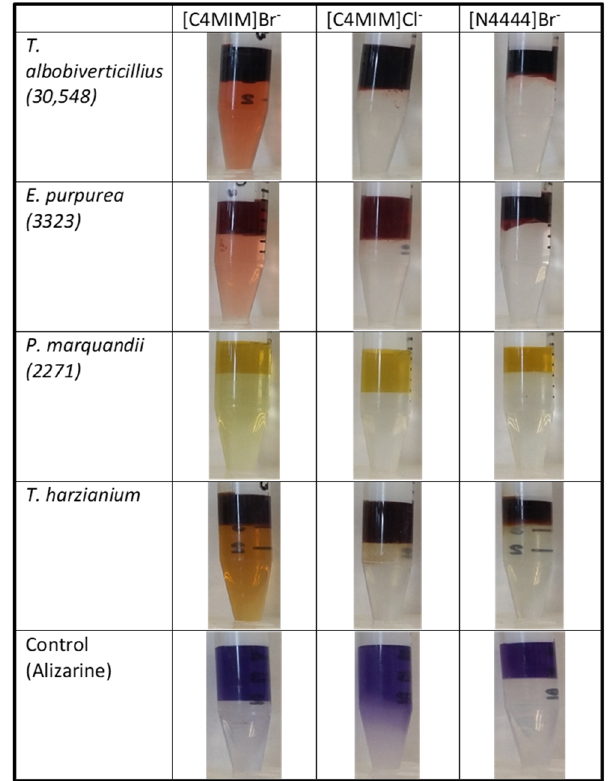
Figure 3. Visual aspect of the first step of extraction from the different IL-ATPSs tested and their extraction abilities on fungal fermentation broth and pure pigment control (alizarin). Lyophilized colored fermentation broths were mixed with the corresponding ionic liquid and salt. The mixtures were allowed to equilibrate for 30 min before centrifugation for 5 min at 4000 rpm and overnight decantation. Both ionic liquid-rich and salt-rich phases were collected and absorbances were measured. Top phase: ionic liquid-rich phase where most of the pigments migrated; Bottom phase: salt-rich phase. The coe ffi cients of partition of distinct pigment shades (K red , K orange and K yellow ) express